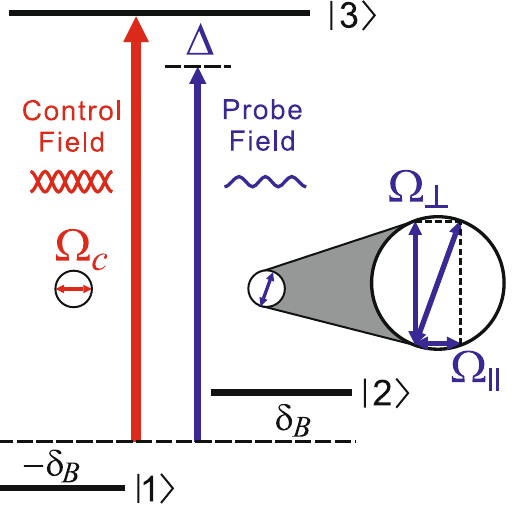
Figure 1. Schematic diagram of linearly polarized (represented by the double-headed arrow in circle) control field and probe field interacting with the three-level atomic